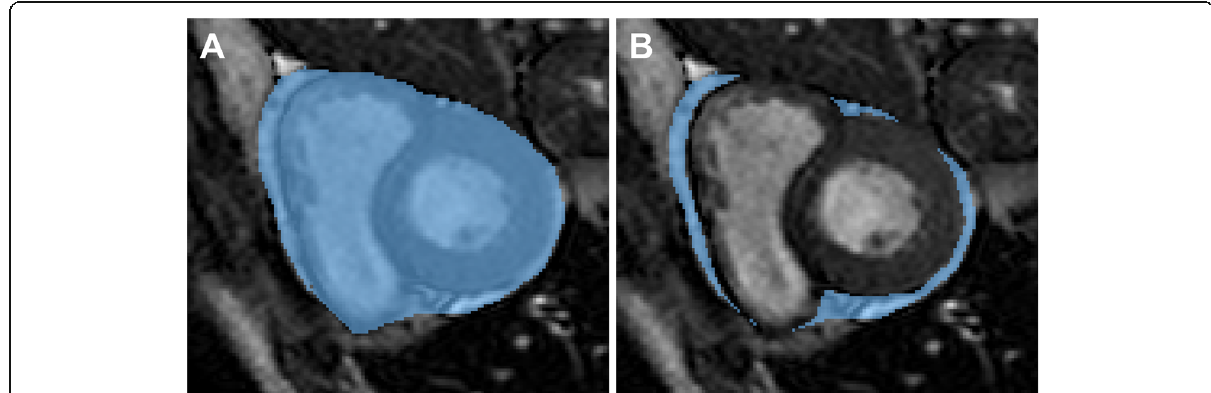
Fig. 1 Segmentation of the pericardium ( A ) with subsequent subtraction of the epicardium ( B ) to obtain an estimate of epicardial adipose tissue volume in an image obtained from a cine sequence in short axis acquired on an open-bore MR scanner in a 44-year-old male patient referred for bariatric surgery